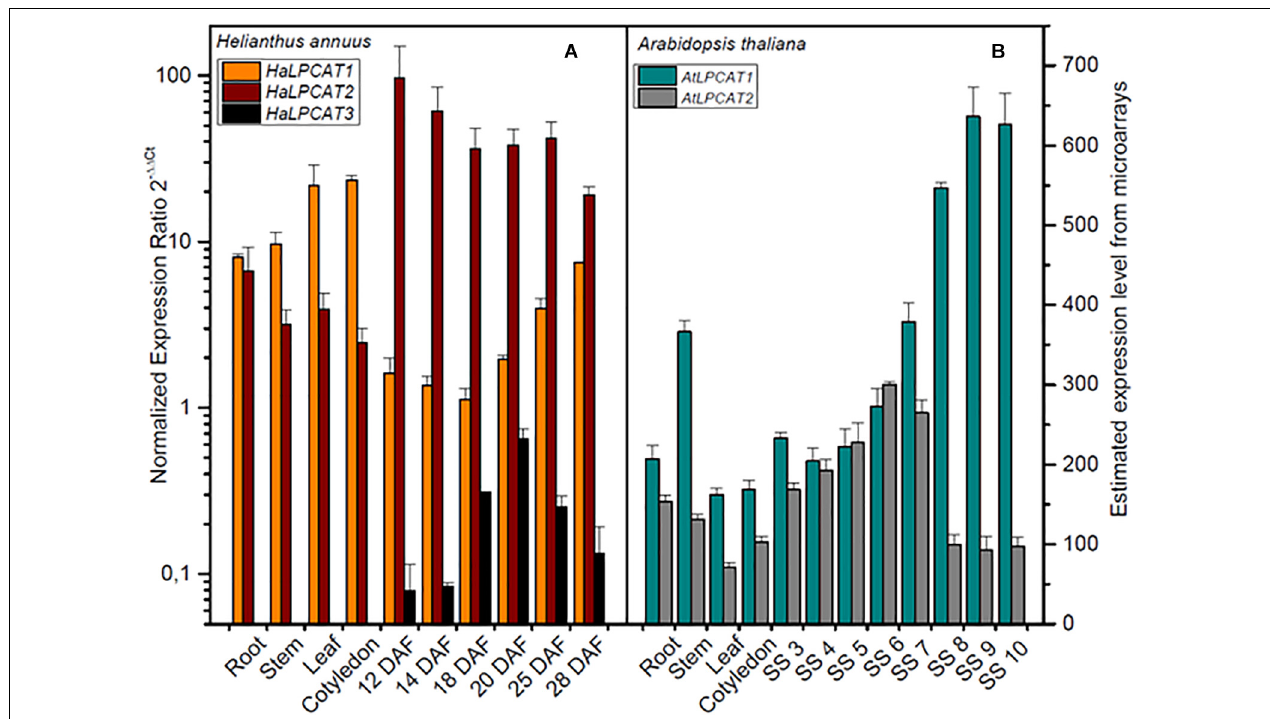
FIGURE 2 | Expression levels of LPCATs sunflower (A) and Arabidopsis (B) in developing seeds and vegetative tissues. Sunflower genes expression was determined by qRT-PCR using the actin gene from H. annuus (GenBank FJ487620) as a reference gene. The data correspond to the mean ± SD from three independent measurements. Arabidopsis thaliana LPCAT gene expression was taken from microarray data (Schmid et al., 2005): DAF, days after flowering; SS 3, mid-globular to early heart embryos; SS 4, early to late heart embryos; SS 5, late heart to mid-torpedo embryos; SS 6, mid to late torpedo embryos; SS 7, late torpedo to early walking-stick embryos; SS 8, walking-stick to early curled cotyledons embryos; SS 9, curled cotyledons to early green cotyledon embryos; SS 10, dry